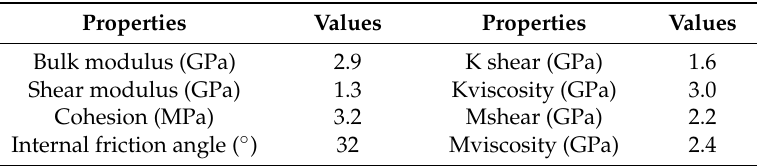
Table 3. Mechanical parameters of